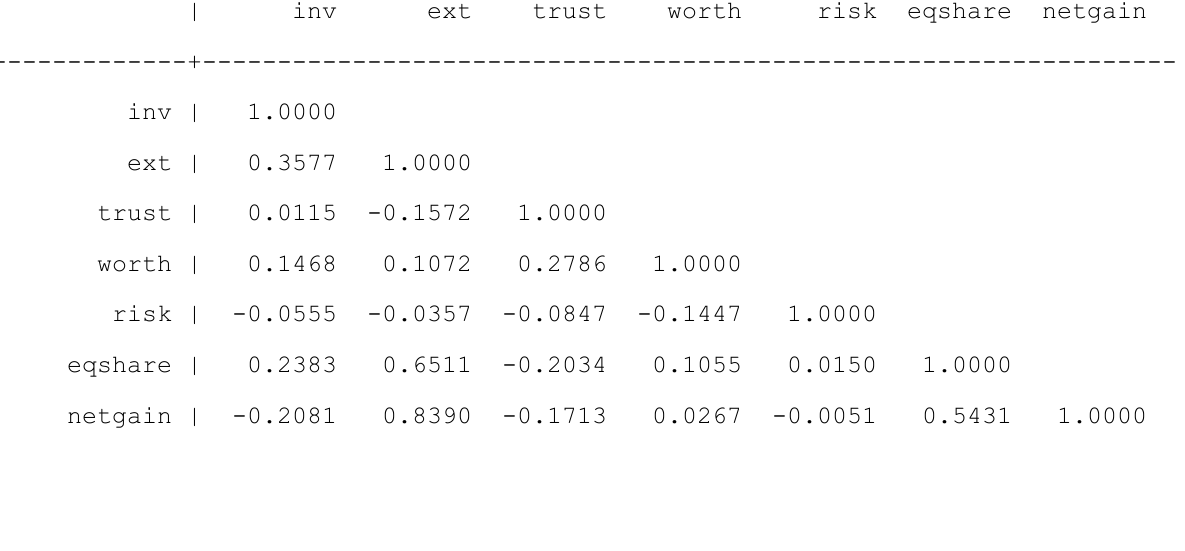
Table S2: Correlogram for variables at the group level (only continuous variables) | avginv avgext avgtrust avgworth avgrisk